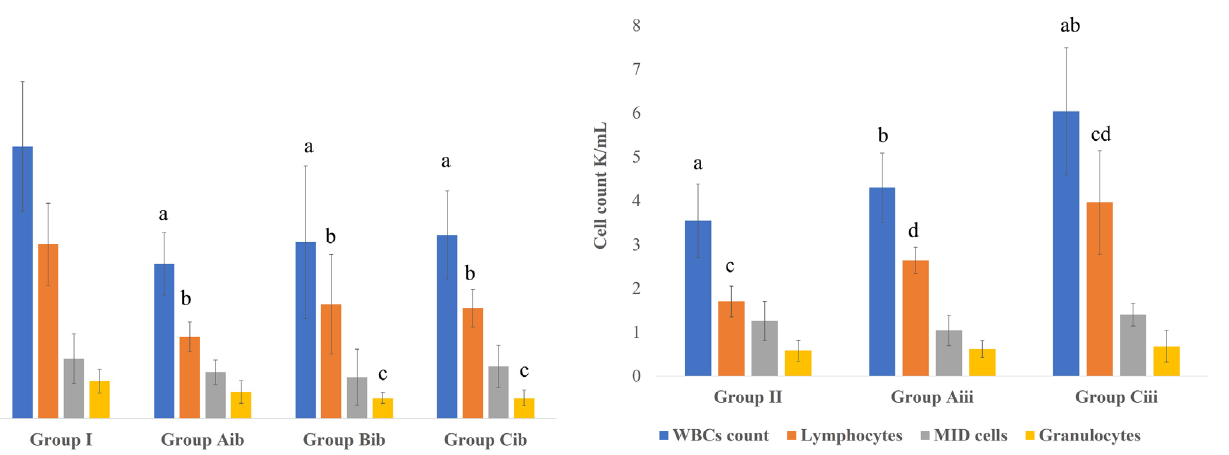
Fig. 12. A chart shows WBCs results (mean± standard deviation) of subgroups treated for 2 weeks with either Nigella Sativa (NS) or ( – )-epigallocatechin-3-gallate (EGCG) then, with 7,12-dimethylbenza [a]anthracene (DMBA) combined with either NS (Aiii) or EGCG (Ciii) for 6 weeks as compared to each other and to DMBA-treated group (G II). MID: Less frequently occurring cells such as monocytes, eosinophils, basophils and other precursor white cells. abcd Indicate that a signi fi cant difference ( P value < 0.05) exists between compared sub/ groups that are marked with the same